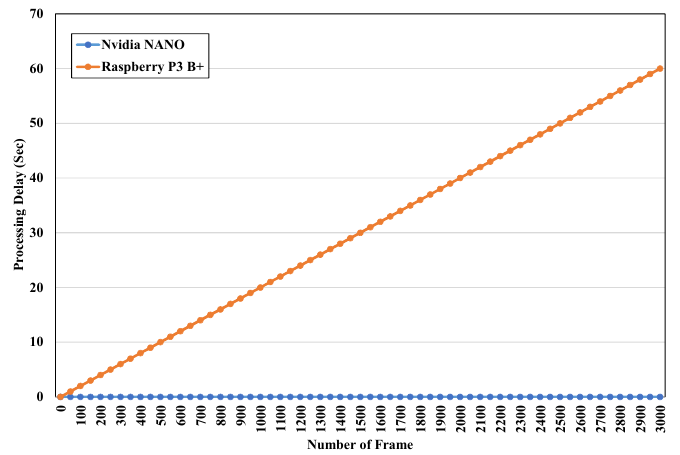
Figure 7. Processing delay of Raspberry Pi 3B+ and Nvidia